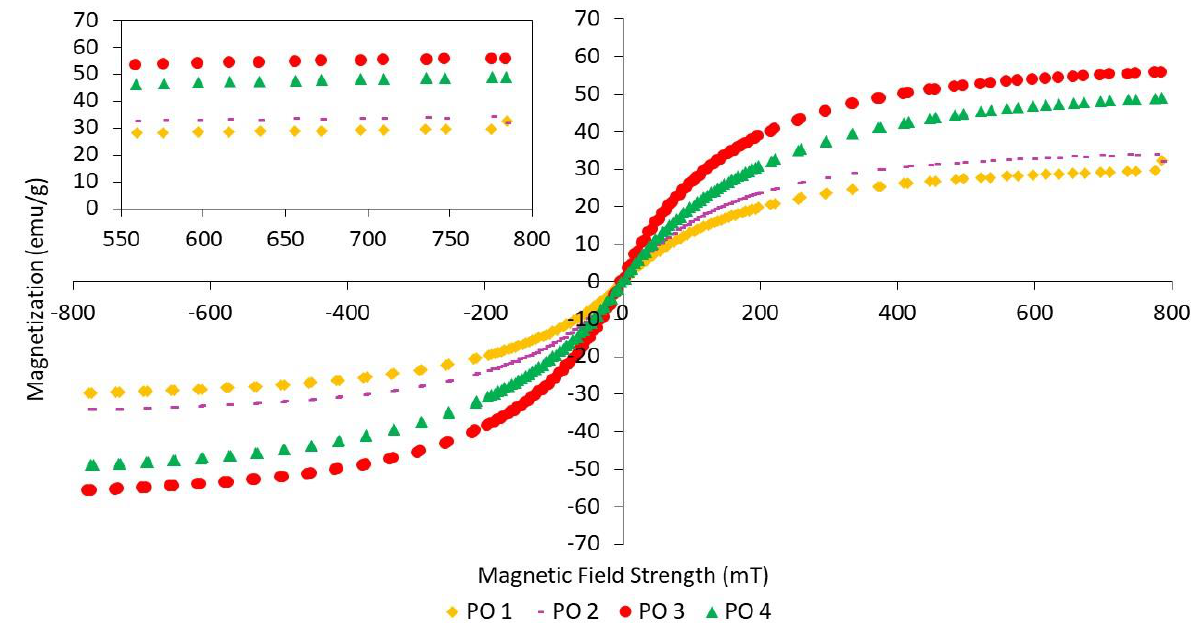
Figure 9. Magnetization curves of NR-based MREs for different ratios of PO:AO. Table 7 represents the M S , M R , and H C for different ratios of PBO, where the values are obtained from Figure 7. Apparently, NO 1 showed good magnetic properties, whereby the sample produced the highest magnetic saturation of 40.06 emu/g. The addition of AO at ratios of 70:30 and 50:50 resulted in a decrease in the value of magnetic saturation from 28.73 to 17.23 emu/g. However, magnetic saturation was slightly increased in the case